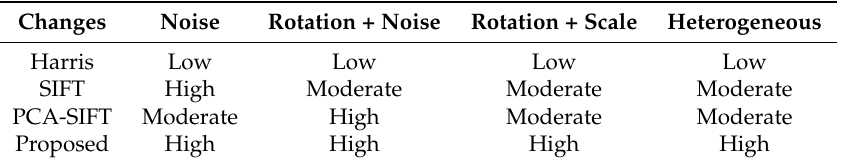
Table 1. Performance levels of correct